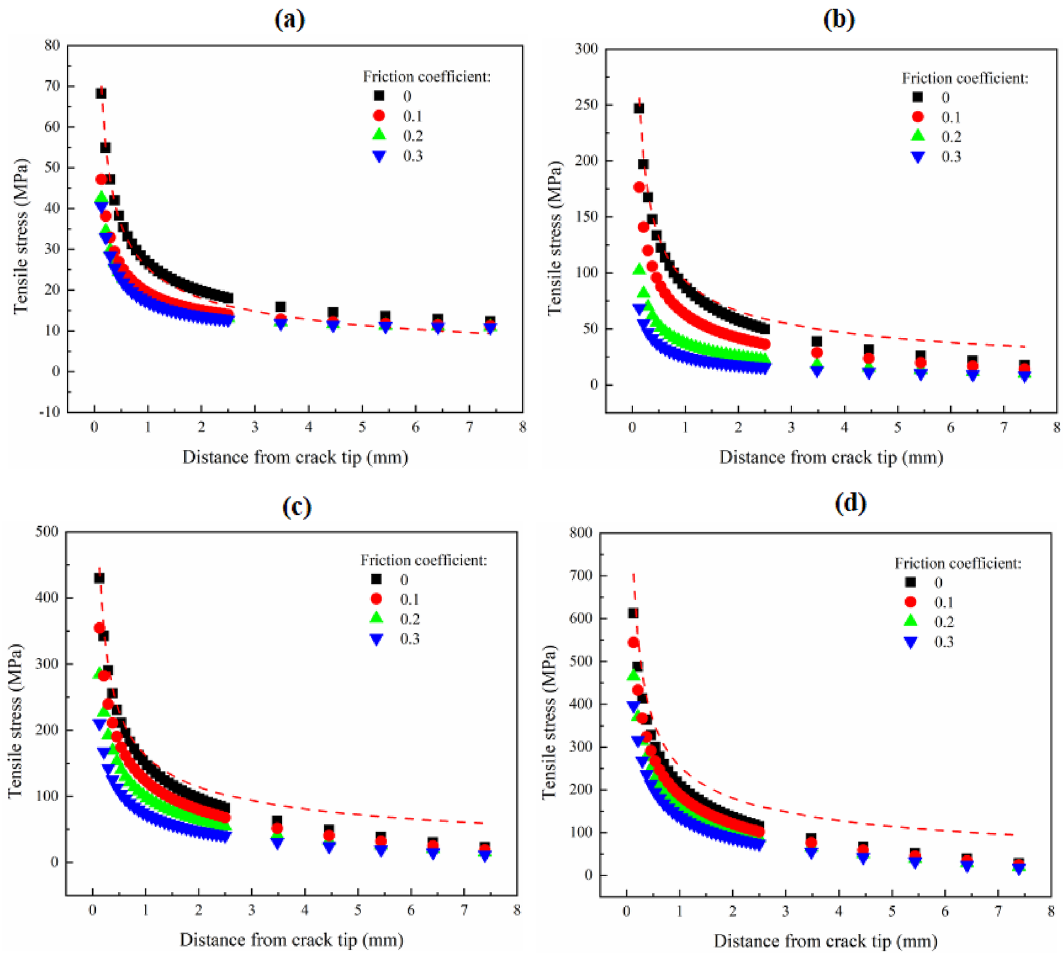
Figure 8. Variation of tensile stress at the front of crack tip with the span of roller support under different friction coefficients. Where ( a ) is S / R = 0.2; ( b ) is S / R = 0.4; ( c ) is S / R = 0.6; and ( d ) is S / R = 0.8. Red dotted lines indicates the tensile stress determined by stress intensity factor that in the friction-free